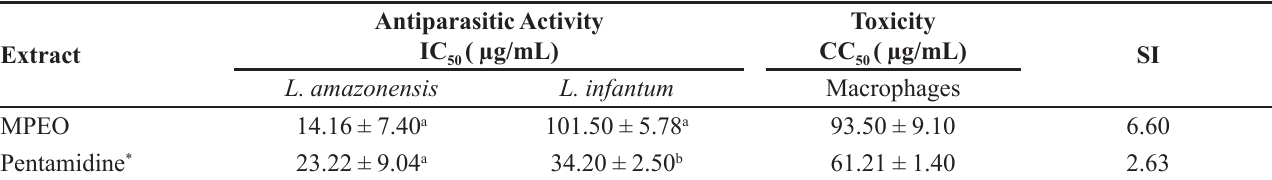
(µg/mL) value of essential oil of M. plinioides against promastigotes of L. amazonensis and L. infantum and CC TABLE II - IC 50 (µg/mL) value of cytoxicity against murine peritoneal